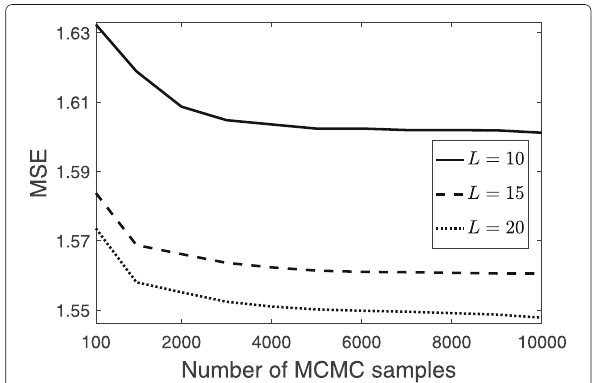
Fig. 10 Effect of the number of MCMC samples on the performance of the